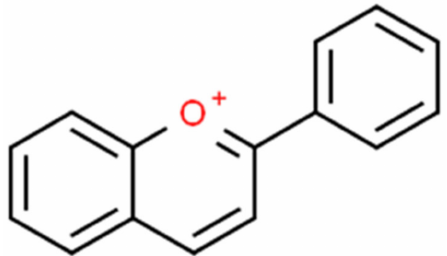
Figure 7. Basic anthocyanin structure—flavylium